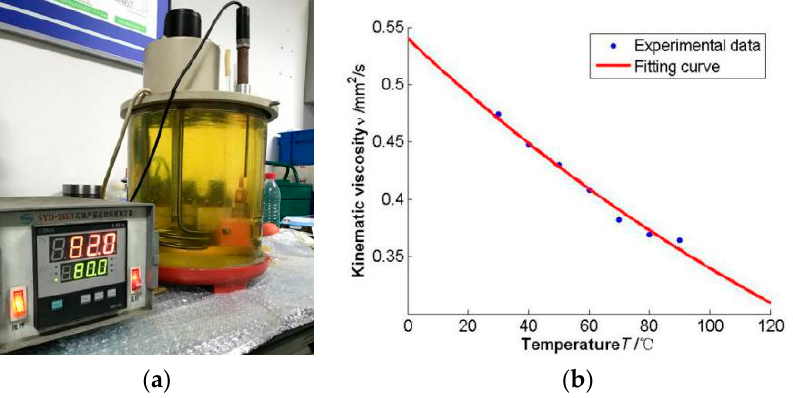
Figure 1. ( a ) The experimental setup for the capillary viscometer method. ( b ) The fitting curve of the viscosity–temperature relationship.